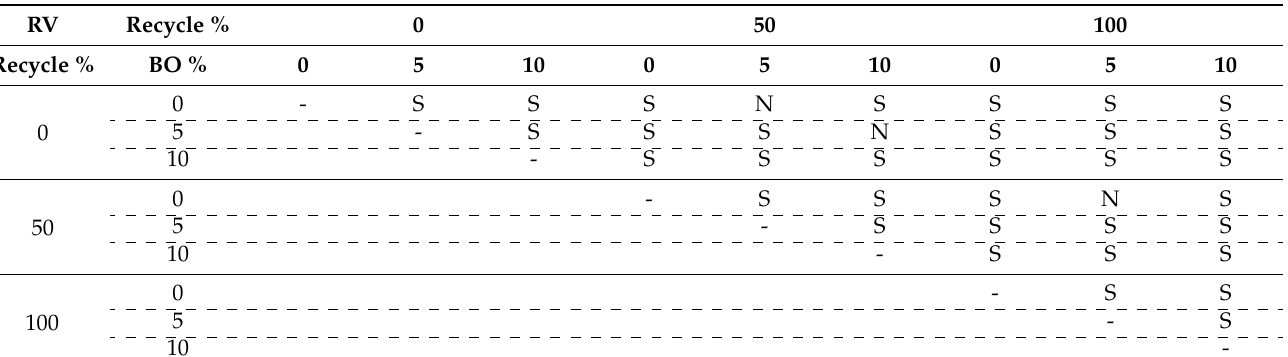
Table 3. Statistical analysis results of the rotational viscosity as a function of aged binder contents and the addition of base oil ( α =